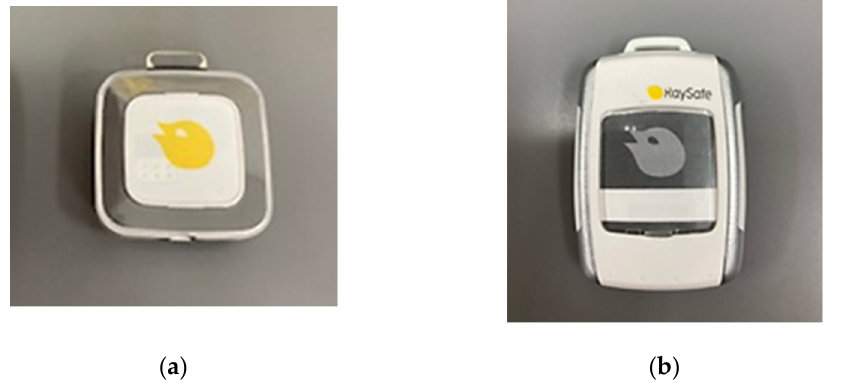
Figure 1. ( a ) The RaySafe i2 sensor (44 × 45 mm); ( b ) The RaySafe i3 sensor (40 × 58 mm). Recently, the i3 sensor has replaced the former i2 sensor.